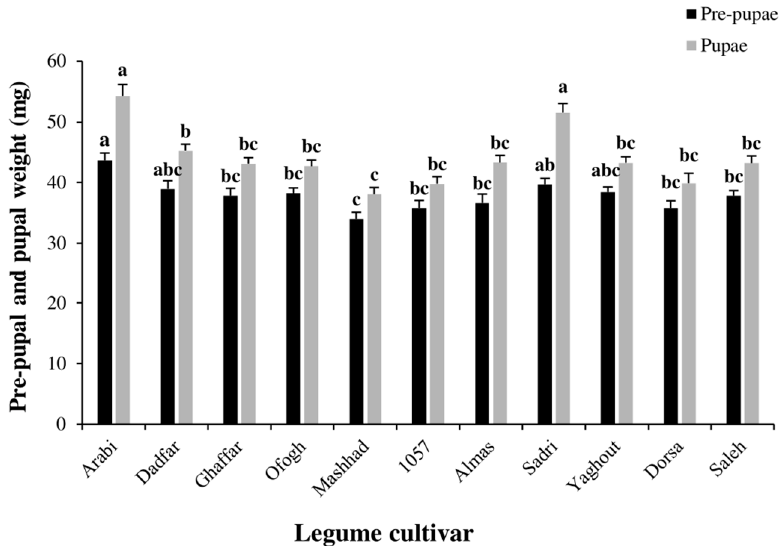
various legume cultivars.